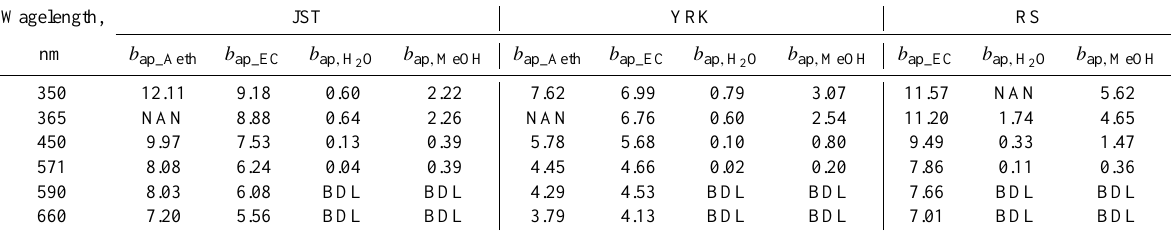
Table 5. Values of Mie-calculated EC absorption ( b ap_EC ) , water-soluble fine particle brown carbon absorption ( b ap , H fine particle brown carbon absorption ( b ap , MeOH ) , and scattering corrected Aethalometer absorption ( b ap_Aeth ) for various wavelengths at all three sites. Units are Mm − 1 . Data are averages for cases of multiple MOUDI measurements at a given site and are also plotted in Fig. 6.